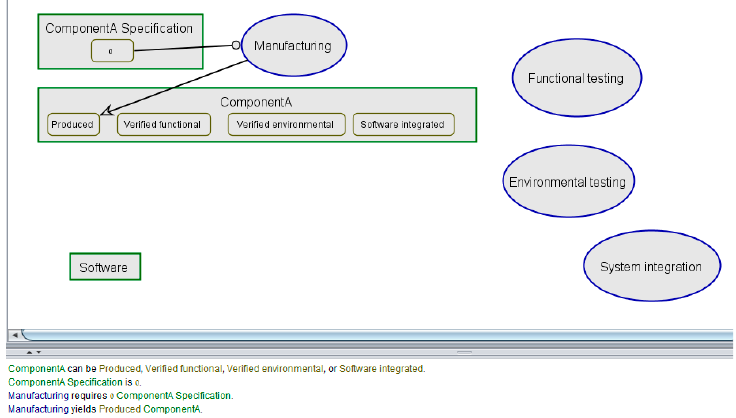
Figure 7. Linking objects and process, option #6.